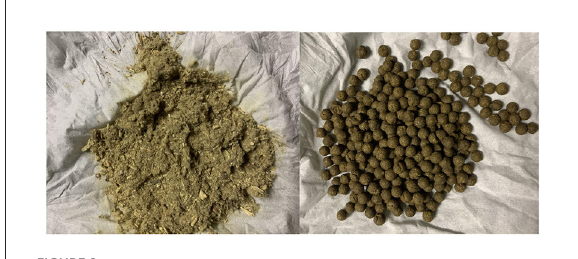
FIGURE2 The patient took traditional Chinese medicine powder and